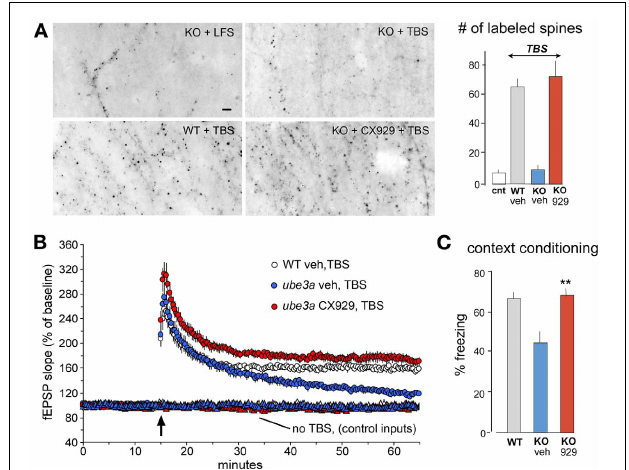
FIGURE 6 | In vivo ampakine treatments rescue TBS-induced spine actin polymerization and LTP in a mouse model of Angelman syndrome. Wild type (WT) mice and mutants with a knockout (KO) of the maternal Ube3a gene (AS mice) were treated with the ampakine CX929 or vehicle daily for 5 days prior to the preparation of acute hippocampal slices. (A) In situ phalloidin labeling was used to assess effects of genotype and treatment on the marked increase in spine F-actin that normally follows TBS. Images and quantification of F-actin rich (phalloidin-labeled) spines show that TBS does not increase the number of such spines in slices prepared from KOs treated with vehicle (veh) relative to counts from slices receiving control (cnt) low frequency stimulation (LFS) only. In contrast, the same stimulation applied to slices from KO mice previously treated with CX929 in vivo (lower right image) elicits a striking increase in F-actin rich spines that is comparable to that obtained in WTs (lower left image). (B) Plots of fEPSP responses show that TBS (arrow) elicits initial potentiation in all groups but the effect slowly decays back to baseline levels in vehicle-treated Ube3a mutants ( ube3a veh). However, slices from mutants given CX929 in vivo ( ube3a cx929) exhibit the conventional LTP effect. (C) Bar graph shows that context fear conditioning is also rescued in the KOs treated with CX929 ( ∗∗ p < 0 . 01 vs. KO veh). Adapted from Baudry et al.